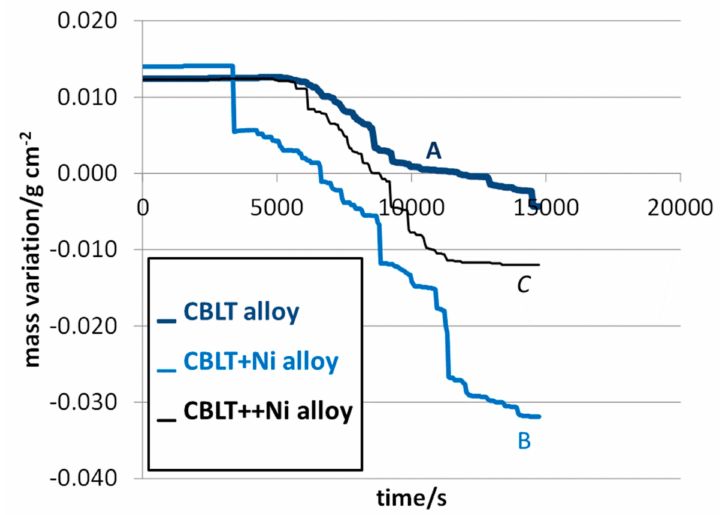
Figure 7. The cooling parts of the TG curves (plotted as mass variation versus time, after correction from the consequence of the air density variation): A: the CBLT alloy; B: the CBLT+Ni alloy; C: the CBLT++Ni